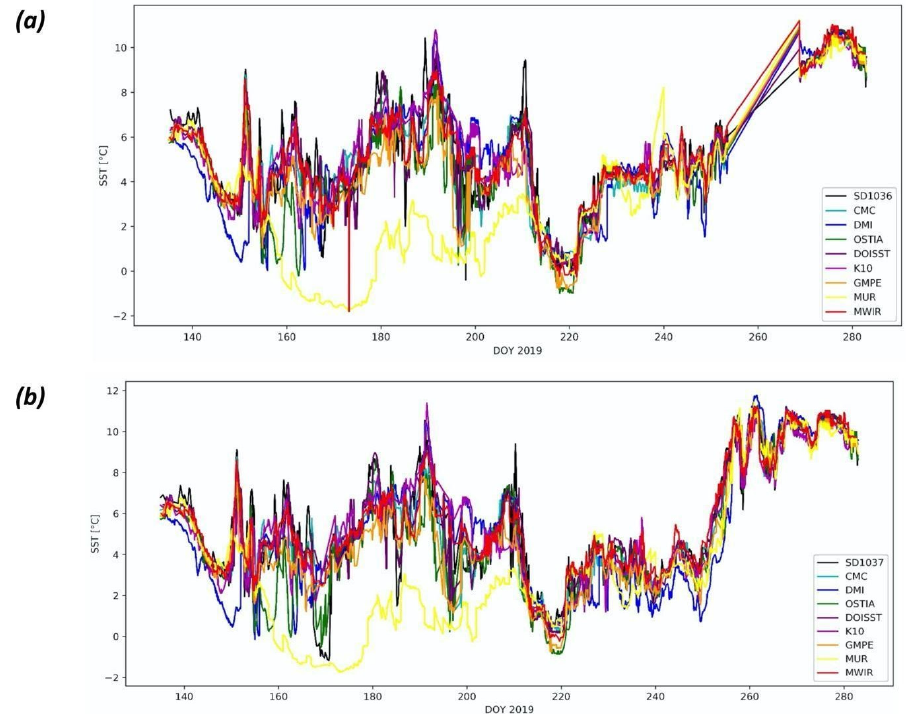
Figure 2. Time series of GHRSST L4 SST products, co-located with the SBE37 SSTs, onboard saildrones ( a ) SD1036 and ( b ) SD1037.